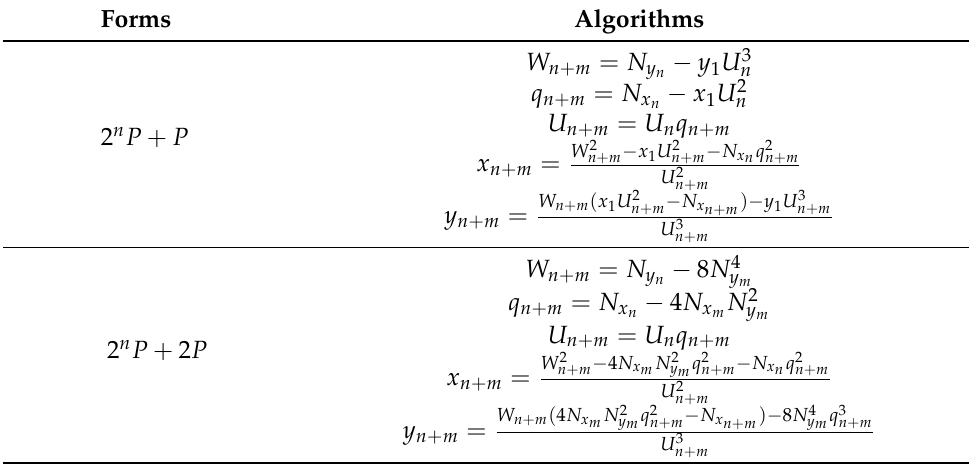
Table 1. Intermediate Algorithms General